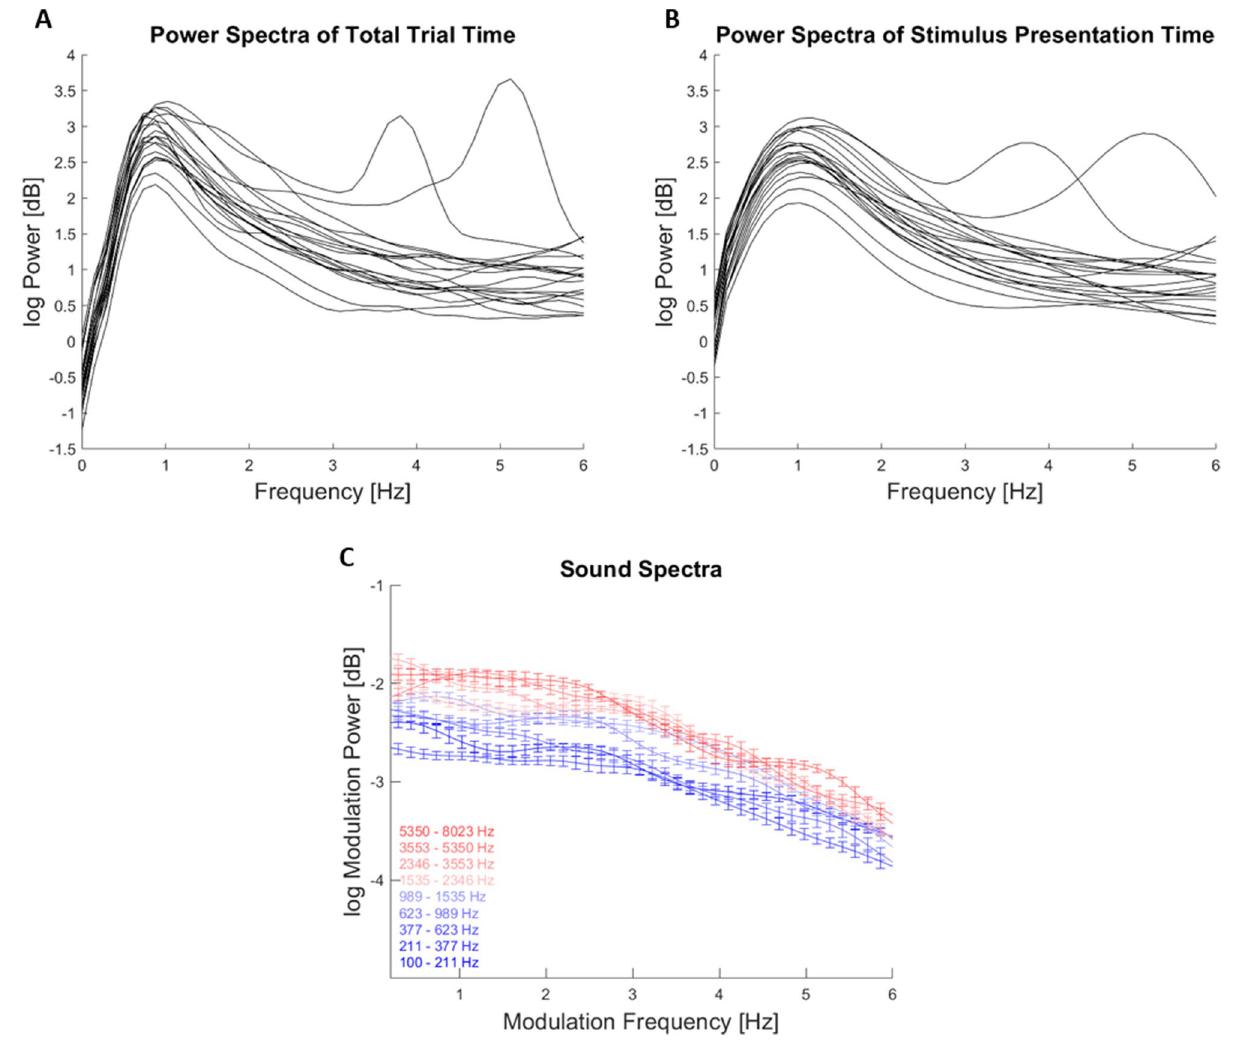
Figure 6. Power spectra of EEG signals and acoustic envelopes. ( A , B ) Time-and trial-averaged power spectra of the EEG signals, averaged within individual participants over the central electrodes contained in the significant clusters in Fig. 3 J/K. Individual lines indicate data for individual participants, in ( A ) for the entire pre-stimulus and stimulus period, in ( B ) just for the stimulus periods. ( C ) Temporal modulation spectra of the acoustic stimuli, shown for individual carrier bands (color coded). Spectra were averaged across trials for each participant. Lines and error bars indicate the mean and s.e.m. across